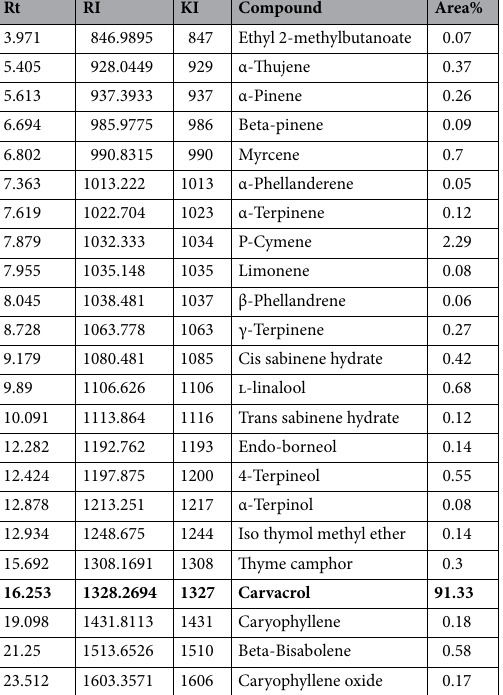
Table 1. Composition of Satureja khuzistanica Jamzad essential oil. RI 1 ; Retention indices determined relative to n-alkanes (C 6 –C 24 ) on a DB-5GC column. RI: Retention indices; MS: mass spectra; Col: co-injection. Significant values are in